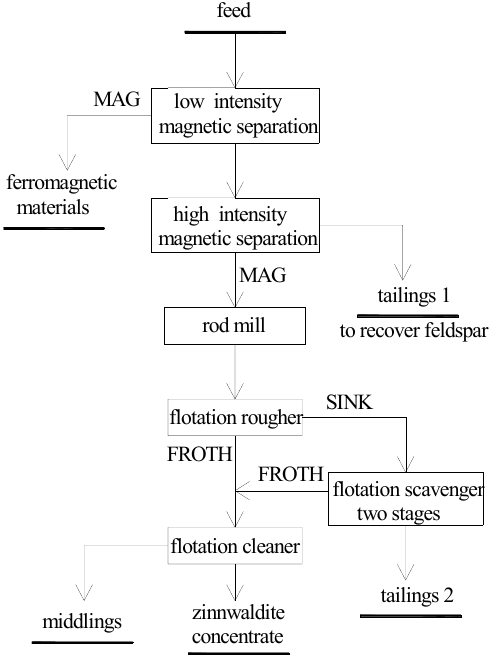
Figure 10. Flow-sheet for beneficiation of Figure 10. Flow ‐ sheet for beneficiation of zinnwaldite.